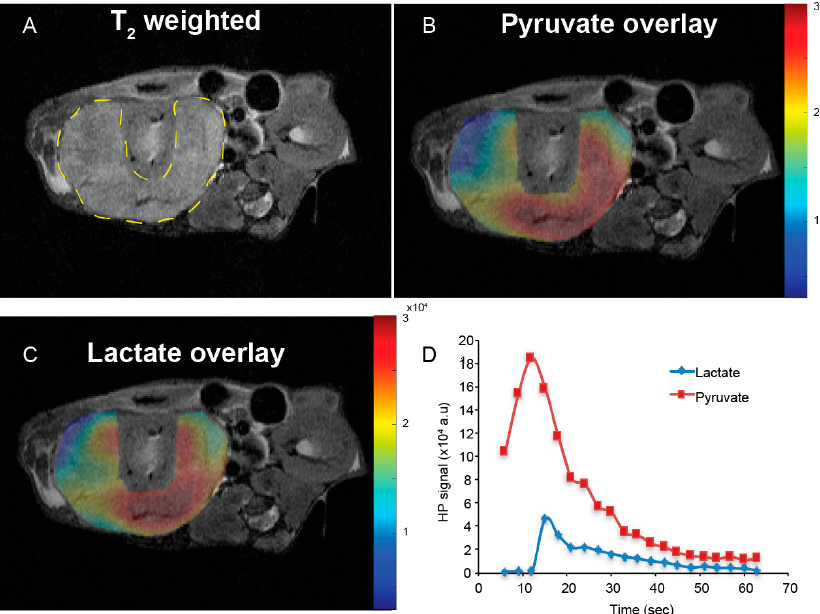
Figure 2. Representative tumor HP 13 C pyruvate and 13 C lactate images and dynamic curves of HP 13 C pyruvate and 13 C lactate signal over time in an A-498 tumor. ( A ) T 2 -weighted anatomic image with the tumor outlined by dashes. ( B ), ( C ) Tumor HP 13 C pyruvate and lactate image overlaid on the T 2 -weighted anatomic image at maximum signal intensity at 12 and 15 s, respectively. The 13 C pyruvate signal in ( B ) is not corrected for the small flip angle. ( D ) Mean tumor signal intensity of HP 13 C pyruvate and lactate over time. 13 C pyruvate signal is flip angle corrected. 13 C lactate signal typically peaks approximately 3–6 s following the peak of the 13 C pyruvate signal.